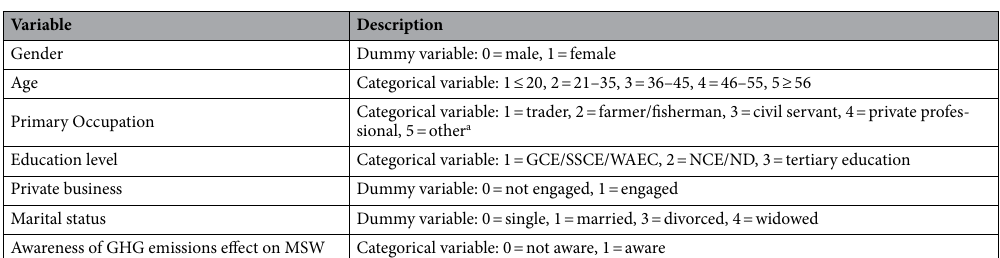
Table 5. Description of variables. GCE General Certificate of Education, SSCE Senior Secondary Certificate Examination, WAEC West African Examination Council, NCE National Certificate of Education, ND National Diploma. a Other = students, retired persons, and